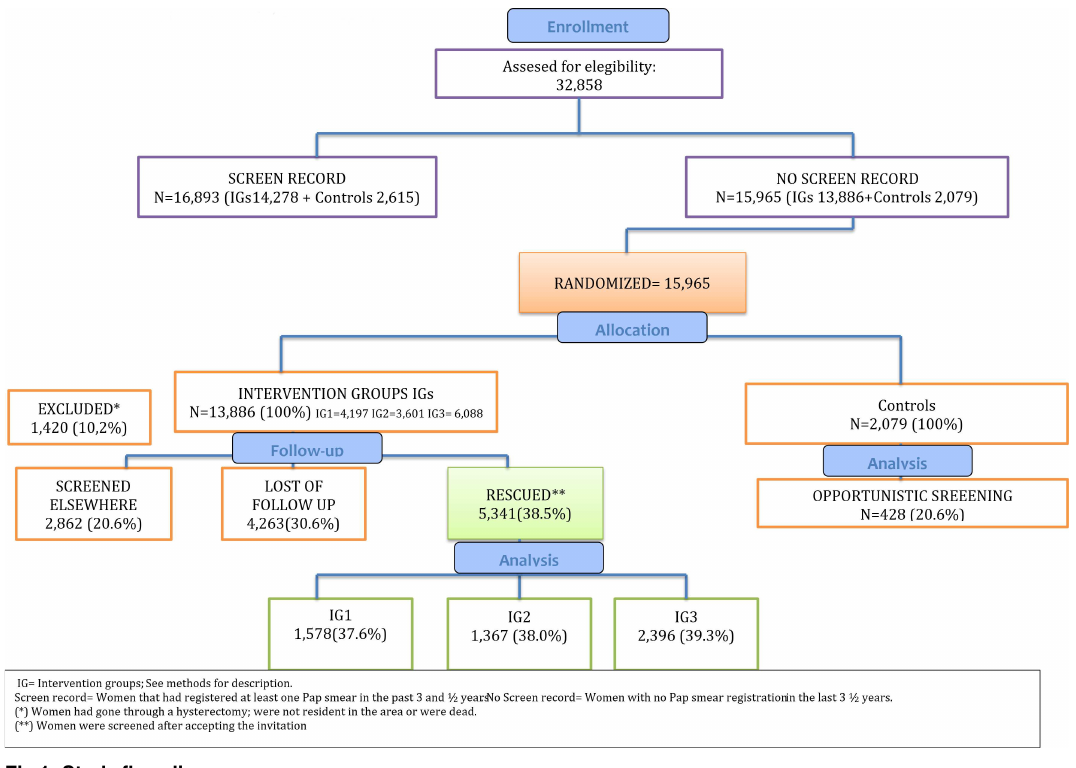
Fig 1. Study flow